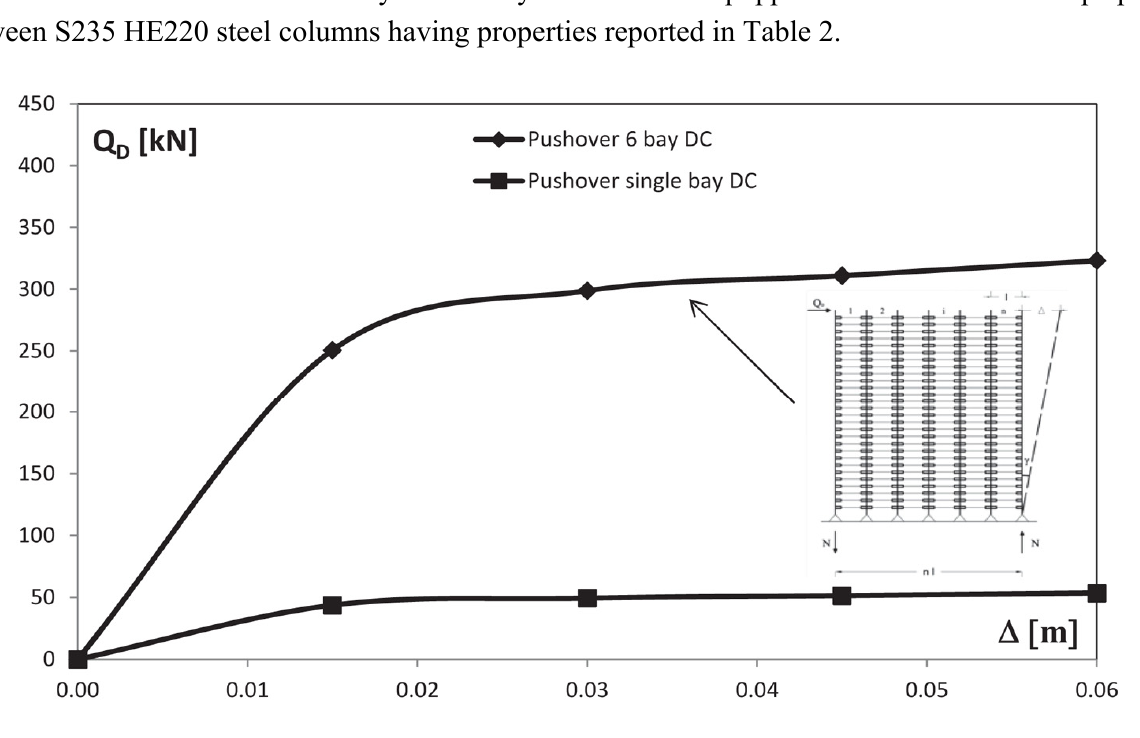
Figure 14. Six bays vs . single bay DC pushover